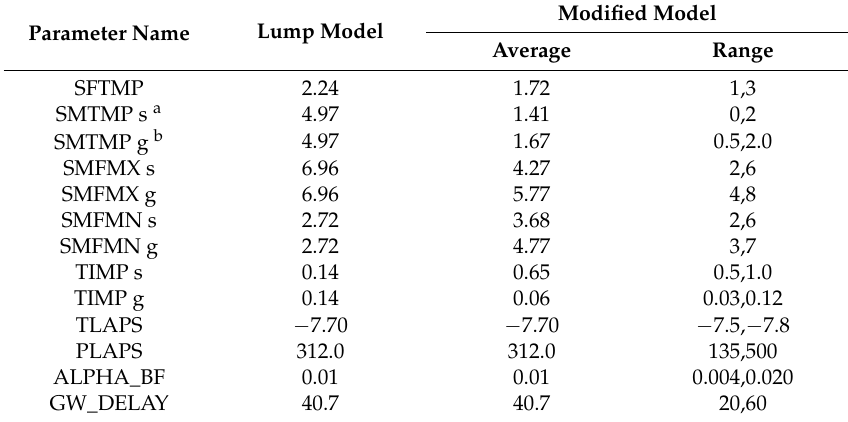
Table 5. Range and mean values of calibration parameters in subbasin-elevation band scale, Vakhsh River